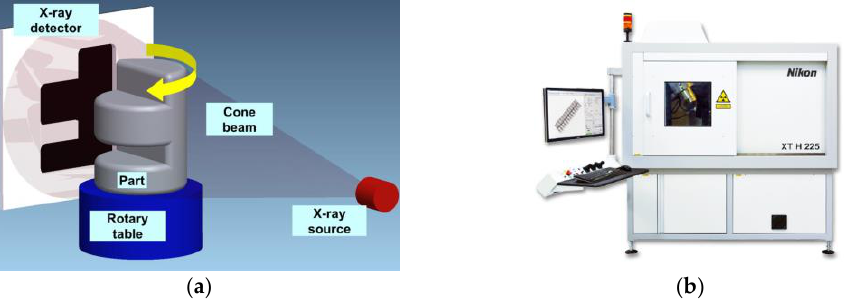
Figure 4. ( a ) Main components of an industrial CT [34]; ( b ) CT system of the type Nikon XT H 225.